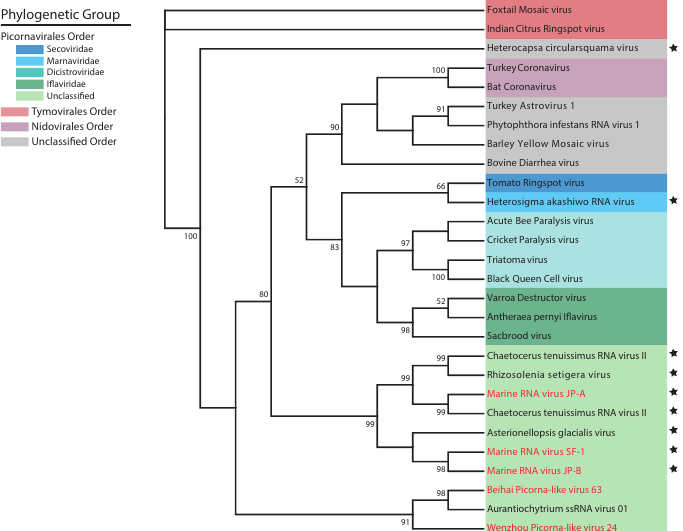
Figure 3. Diversity of single-stranded RNA viruses depicted based on phylogeny of RNA-dependent RNA polymerase (Rdrp NCBI CDD:01699) reference sequences downloaded from NCBI RefSeq database (see in Supplemental Table S1). Sequences were aligned and trimmed in Mega7 [117] and an unrooted maximum likelihood phylogeny was created using PhyML 3.0 with LG model [118]. Empirical equilibrium frequencies were used with aLRT SH-like statistics for branch support. Phylogenetic groups are color coded with algal viruses denoted by a star. Viral isolates from metagenomic assemblies are in red